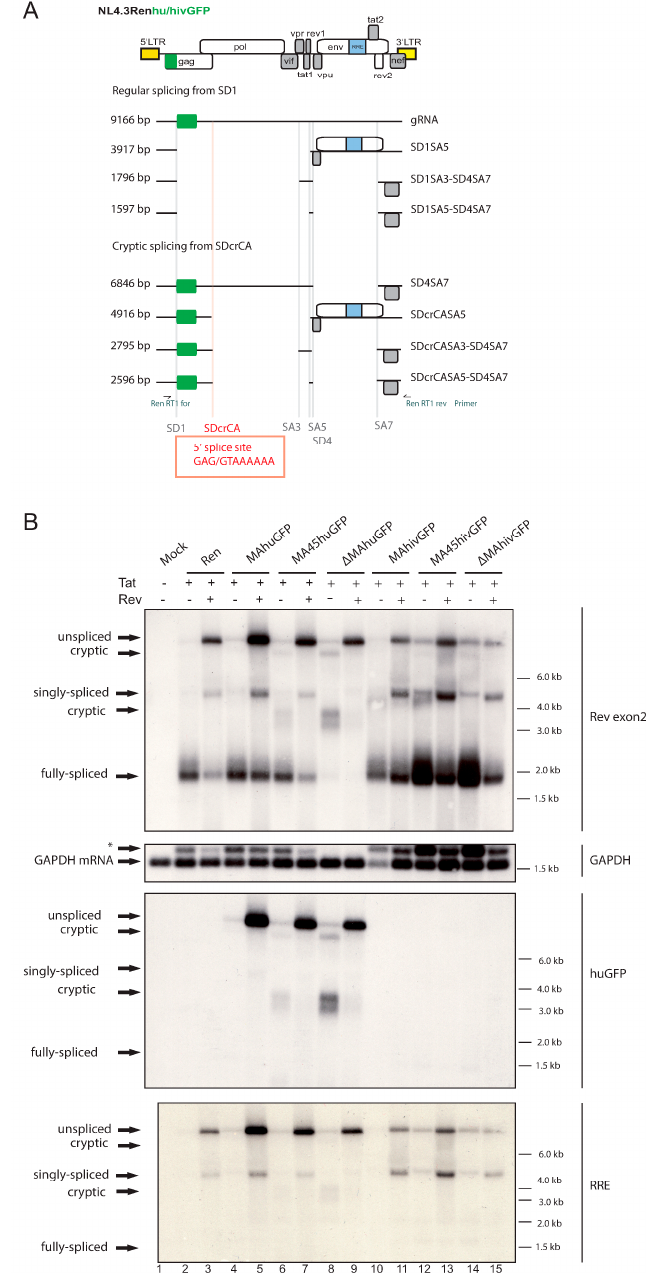
Figure 2. huGFP misregulates HIV-1 splicing in a position-dependent manner. ( A ) Depiction of the proviral genome (top panel). The predicted splice variants for the ∆ MAhuGFP construct are shown below. In the upper part, splicing from the regular splice donor 1 (SD1) is depicted and in the lower part, splicing events from the newly identified cryptic splice donor (SDcrCA) are shown. The sizes of the RNA variants are given on the left side and the possible combinations of splice donor and acceptor sites are depicted on the right margin. At the very bottom, the splice sites are shown with their position on the proviral genome. The primers used for RT-PCR are depicted at the bottom of the panel as half arrows. ( B ) Northern blot of total RNA from HEK 293T cells transfected with the indicated constructs. Membranes were rehybridized with different probes (named on the right-hand side) specific for Rev exon2, huGFP, RRE, and GAPDH, which served as loading control. The different splice variant classes are indicated on the left, sizes are given on the right, and an asterisk marks residual signal from the previous